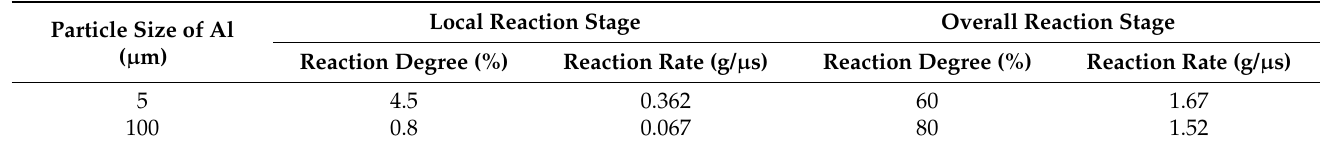
Table 6. Reaction rate of shaped charge projectiles during